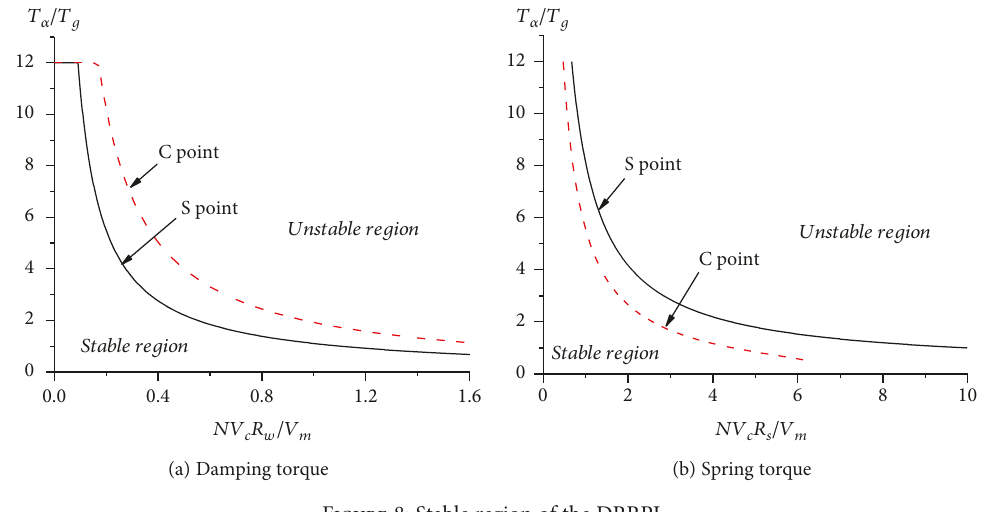
Figure 8: Stable region of the DRRPL.